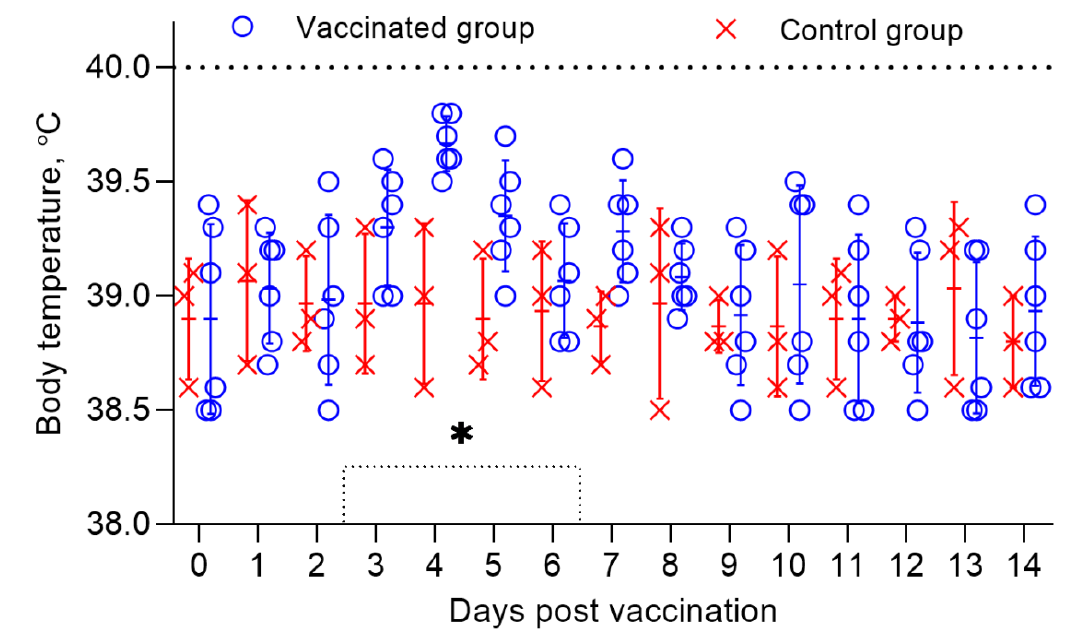
Figure 1. Body temperature of vaccinated sheep when studying the safety of a combined vaccine against PPR and SPP. The dotted line in the graph shows the upper limit of the normal body temperature. Rectal temperatures of 6 vaccinated animals and 3 control animals are shown in the graph. (*) Local reactions that appeared post vaccination in 2 vaccinated sheep existed for 4 days.